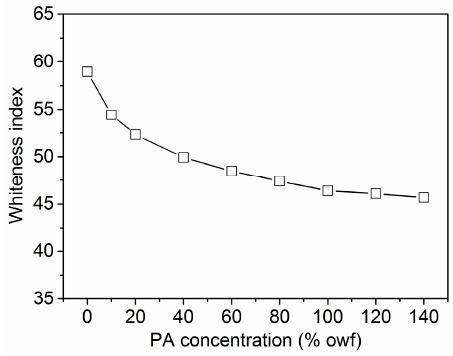
Figure 14. Whiteness of the wool fabrics treated with PA.